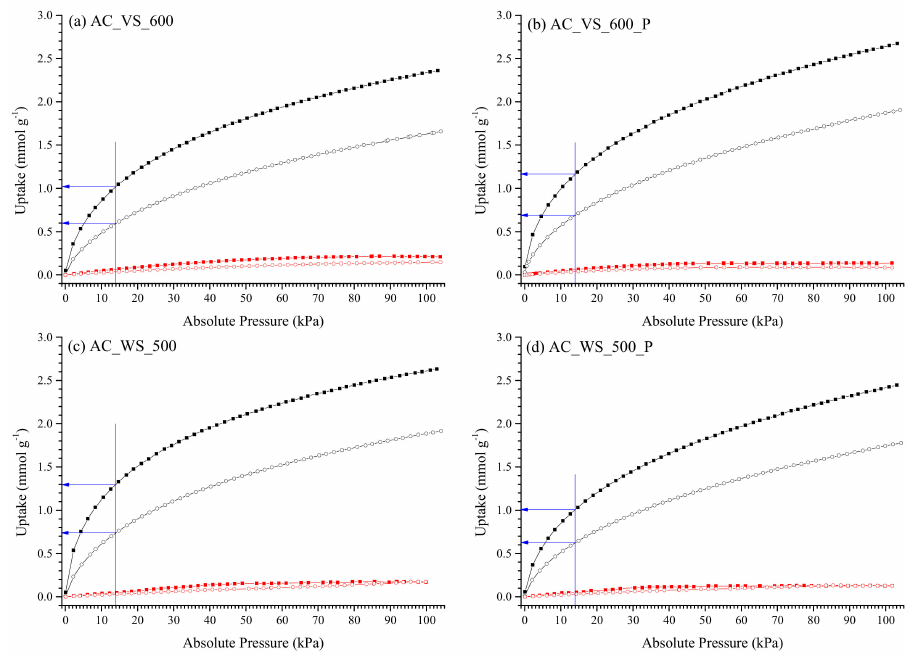
Figure 3. Adsorption isotherms of CO 2 and N 2 on the activated biochars at 25 and 50 ◦ C: AC_VS_600 ( a ), AC_VS_600_P ( b ), AC_WS_500 ( c ), and AC_WS_500_P ( d ).Black filled squares: CO 2 at 25 ◦ C; black open circles: CO 2 at 50 ◦ C; red filled squares: N 2 at 25 ◦ C; red open circles: N 2 at 50 ◦